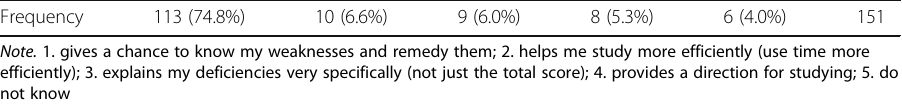
Table 12 Reasons for perceiving Part2 (mastery profile informing strengths and weaknesses) as useful